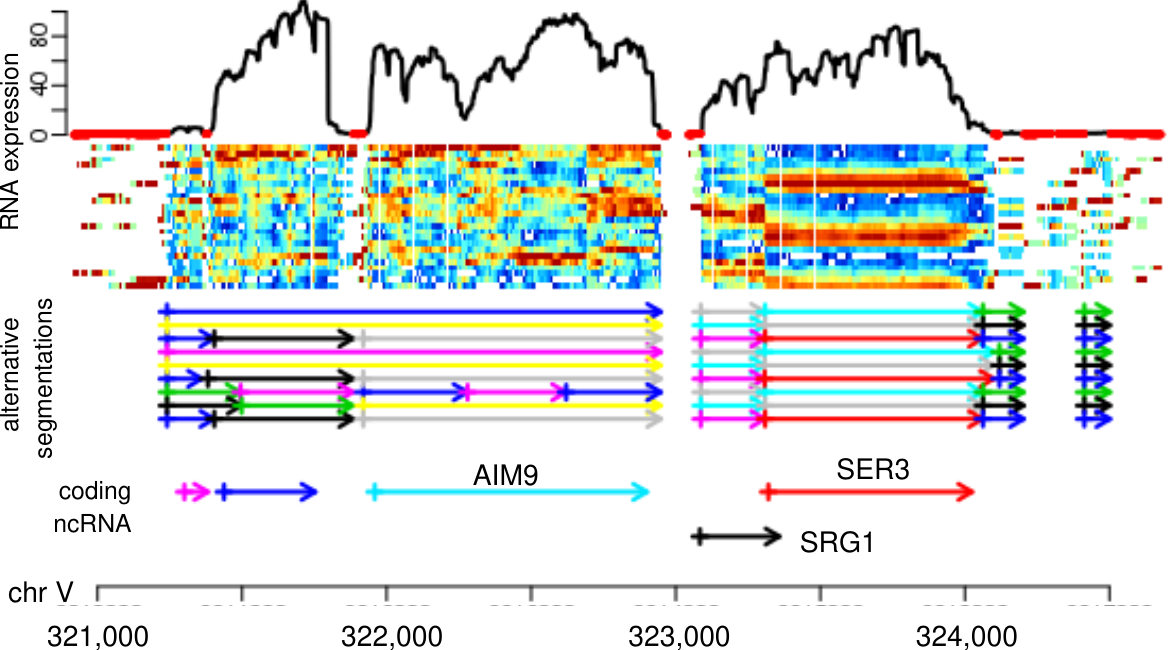
Figure 1. Segmentation of RNA expression patterns. Top: RNA expression in 24 samples taken every 4 min from Saccharomyces cerevisae strain IFO 0233 (shown as color scale, with the total of all experiments shown above). The sequencing data are strand-specific, only the plus strand of about 5000 nt on chromosome V are shown. Middle: nine different segmentations computed with segmenTier using different parameter settings; see Reference [11] for details on data and segmentations. Below: annotated coding and non-coding yeast genes. The rightmost block of short segments is a candidate for an unannotated ncRNA located anti-sense to the much longer protein-coding gene Utp7p on the minus strand. The data are the same as those in Figure 3 of Reference